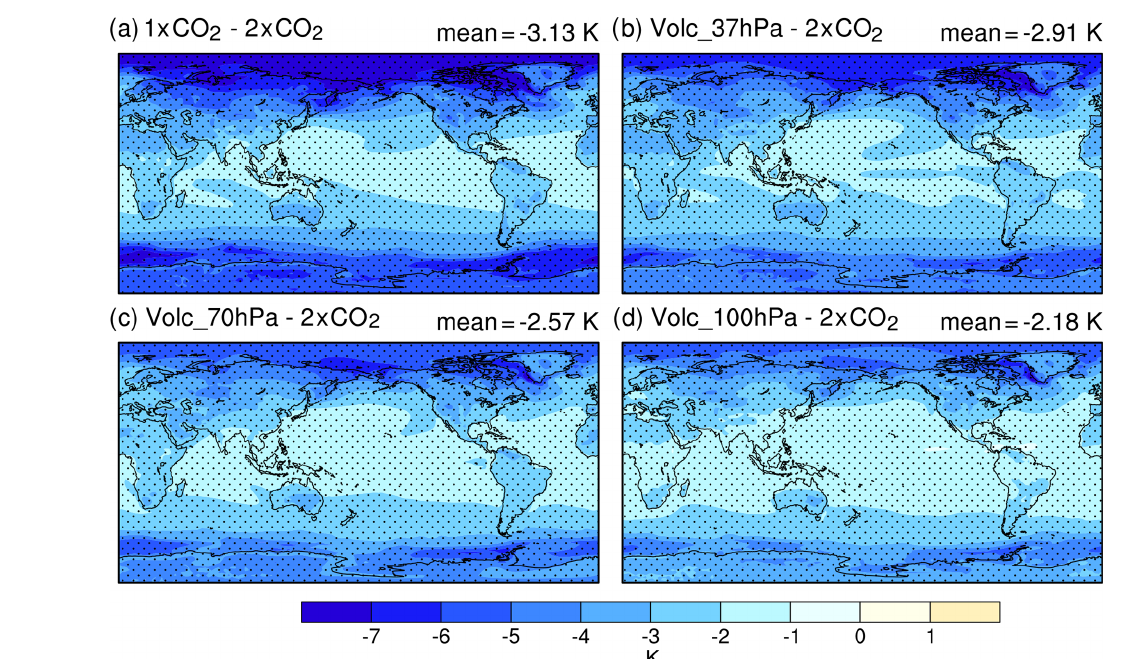
Figure 5. The spatial pattern of changes in the surface temperature relative to the 2XCO2 experiment (slab ocean simulations). The hatched areas show the regions where the changes are significant at the 5% significance level, and the changes are significant over the globe at this significance level in all experiments. The significance level is estimated using Student t test from 60 annual means of the experiments. Global mean value of the changes in each experiment is shown at the top right of each panel.